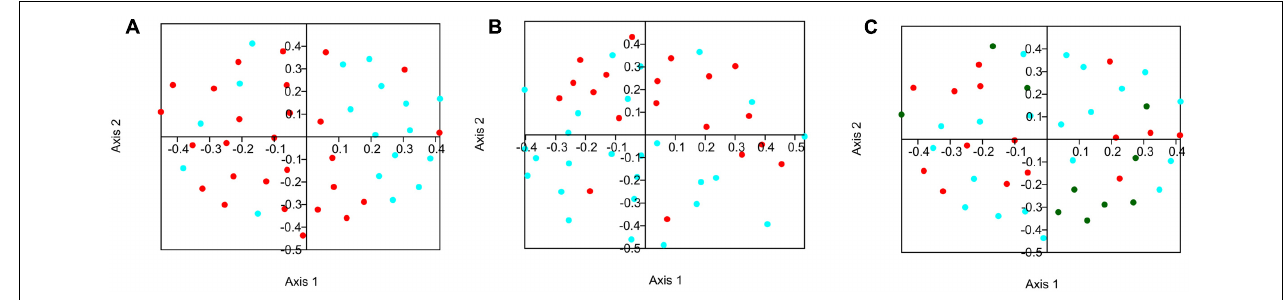
FIGURE 1 | Non-metric multidimensional scaling (NMDS) plot illustrating sow fecal microbiome beta-diversity according to the time of gestation, Salmonella shedding status and number of gestation. (A) Blue = beginning of gestation; Red = end of gestation. (B) Red = shedding; Blue = no shedding. (C) Blue = low number of gestation (1–3); Green = medium number of gestation (4–5) Red = high number of gestation (6–8).